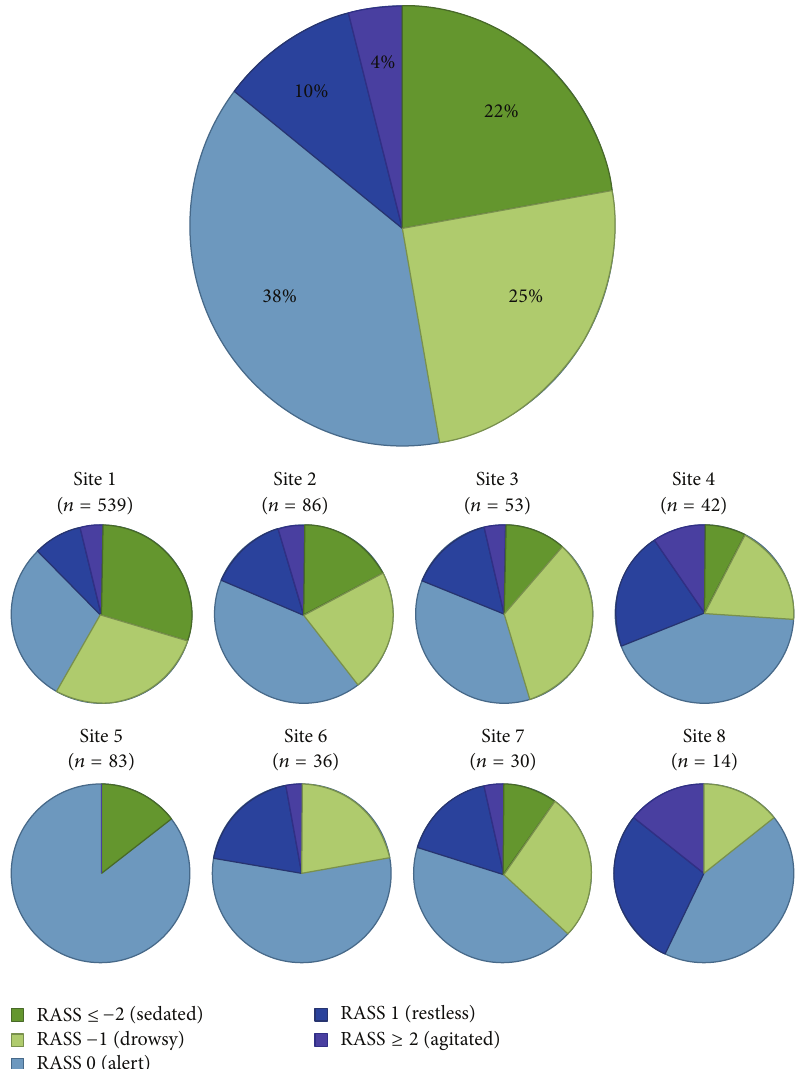
Figure 3: Distribution of Richmond Agitation Scale Score (RASS) ranges overall and across sites. The large pie graph in this figure depicts the overall distribution in RASS scores from all spontaneous breathing trials (SBTs) with available data for sedation. The series of small pie graphs represent the centre-specific distributions, allowing comparison across sites. Values expressed as % proportion of SBTs. 𝑁 values represent the number of SBTs at each site with available